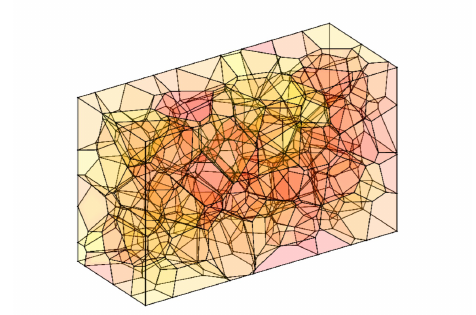
Figure 2. An example of using 3D Voronoi diagram based on hyperuniform points